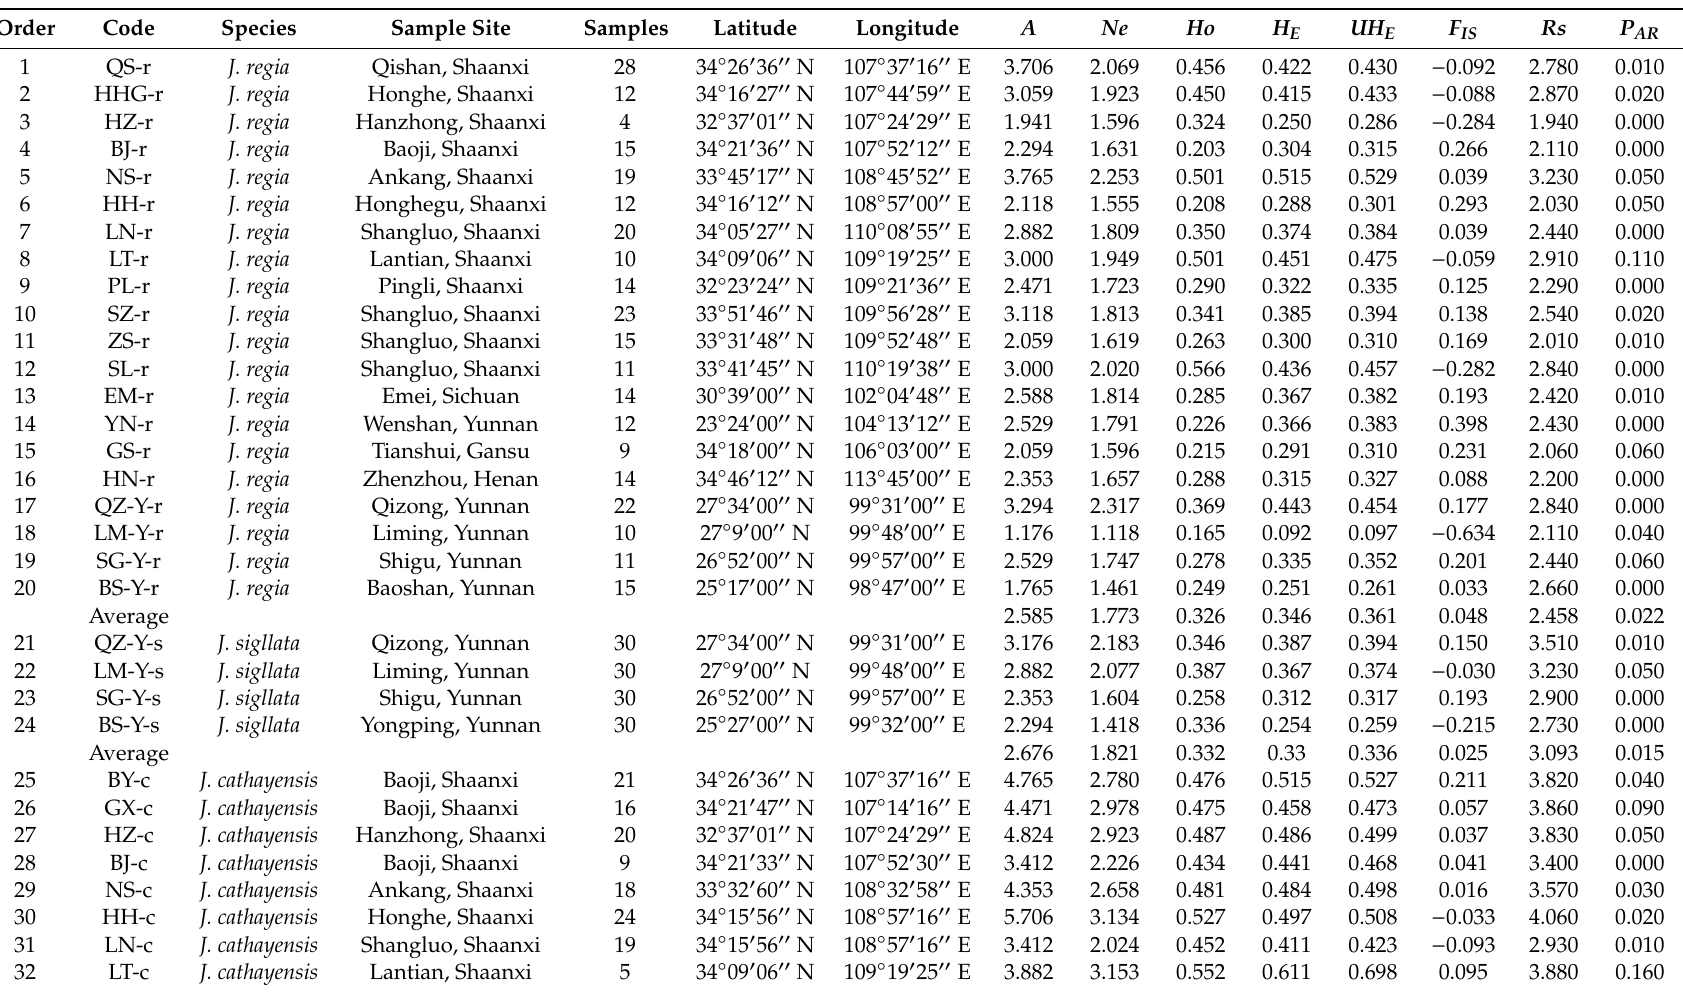
Table 1. Details of sample location, sample size, and descriptive statistics of genetic variability for 18 Juglans regia L. populations, four Juglans sigllata Dode populations, and 14 Juglans cathayensis Dode populations sampled in